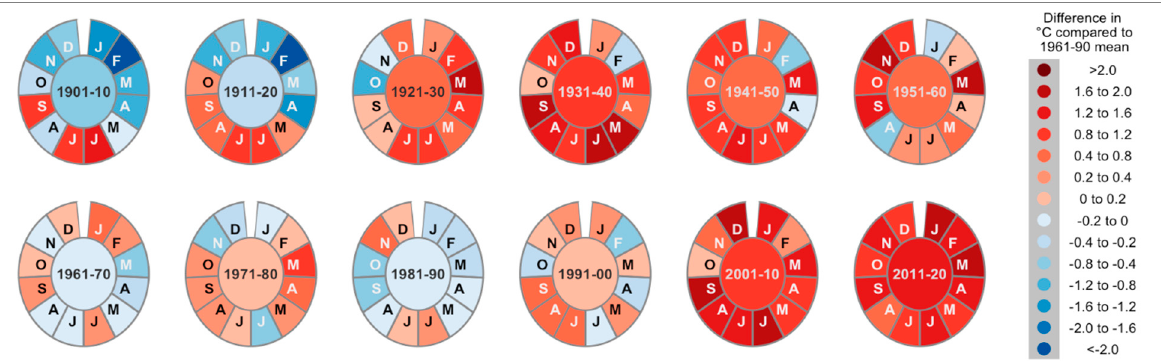
Figure 4. Long-term temperature anomalies for each month per decade, 1901–2020, Bolungarvík average. The figure presents a “temperature circle” for each decade. There are 12 outer segments for each month, labelled chronologically and progressing clockwise. The uppermost and righthand “J” is January, the “F” to the right is February, and so on. Each color represents the difference in degrees